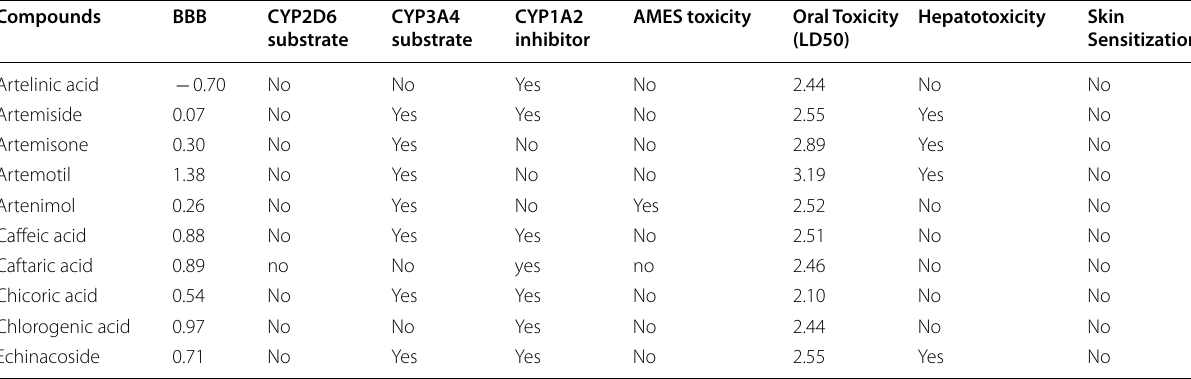
Table 6 ADMET properties of all studied compounds Compounds BBB CYP2D6